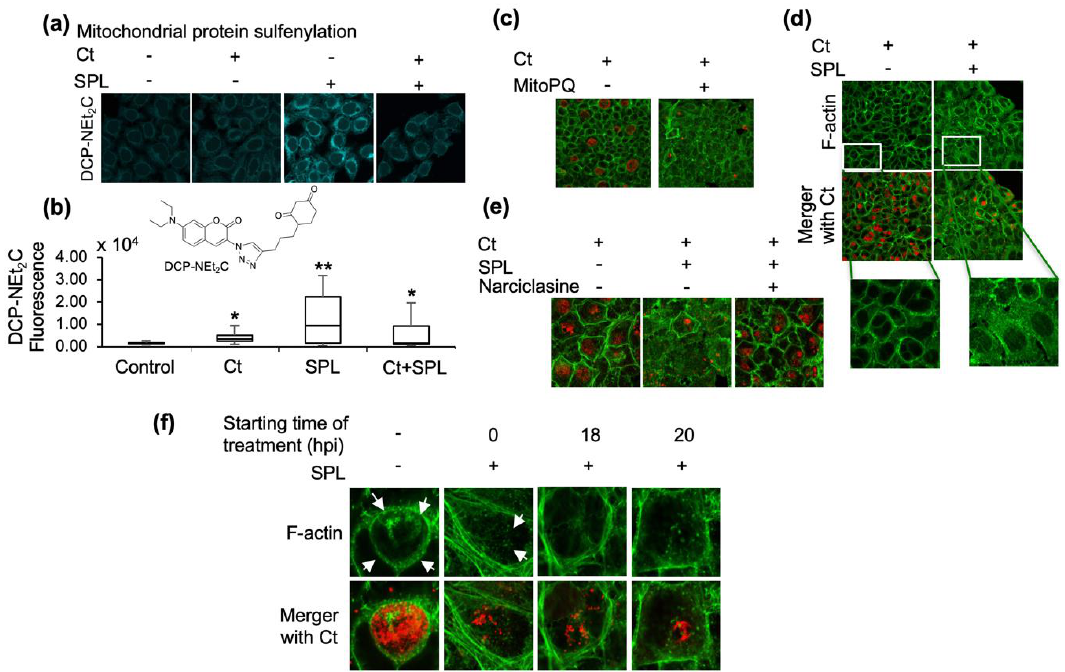
Figure 2. SPL disrupts the formation of F-actin ring and stability of Ct inclusions by increasing mitochondrial oxidative state. ( a ) Confocal imaging analysis of mitochondrial protein sulfenylation induced by Ct and SPL (120 μM) alone or when used in combination. Mitochondrial sulfenylated proteins were imaged with DCP-NEt 2 C; ( b ) Flow cytometry analysis of DCP-NEt 2 C labeled cells to further validate and quantify the effects of Ct and/or SPL treatments. Statistical significance is indicated by the effects size as medium (*, 0.4 < x < 0.7) or large (**, 0.7 < x < 1.2) ( n = 2); ( c ) Disruption of F-actin cytoskeletal organization and Ct inclusions by MitoPQ, a mitochondria-targeted ROS generator. F-actin was detected with Alexa Fluor 488-phalloidin (green) and chlamydial inclusions were detected using anti-MOMP antibody (red); ( d – f ) The same imaging analysis monitoring Ct inclusions and F-actin was performed to investigate the effect of SPL on Ct inclusions and F-actin network ( d ), the rescue of SPL detrimental effects by narciclasine ( e ), and to demonstrate that SPL disrupts the F-actin organization and the ring structure surrounding the Ct inclusion regardless of the time of addition to cells relative to Ct infection (control, Ct infection 24 hpi, 0.1% DMSO). All imaging data are representative of a minimum two biological replicates and were collected at 40x magnification. White arrows point to the F-actin ring.